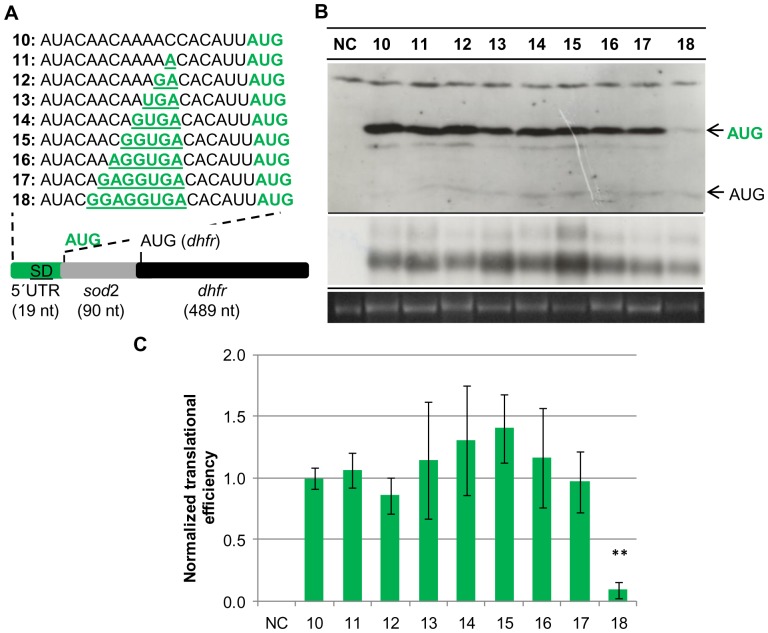
Translational efficiencies of a consecutive SD mutant series under standard conditions.For the comparative analysis of translational efficiencies H. volcanii cultures of pPK10-pPK18 and pNP10 negative control (without hdrA) were grown to mid-exponential growth phase under standard conditions (2.1 M NaCl, 42°C). A. Schematic overview of the reporter gene constructs pPK10-pPK18. The SD sequence (green and underlined) was mutated as indicated. B. One representative example of three independent experiments is shown for a Western blot analysis (upper panel), a Northern blot analysis (middle panel), and the 16S rRNA of an agarose gel used for normalization. The protein and transcript levels were analyzed as described in Experimental Procedures. The results are summarized in Table S2. C. Graphic representation of the normalized average translational efficiencies and their standard deviations (n = 3).